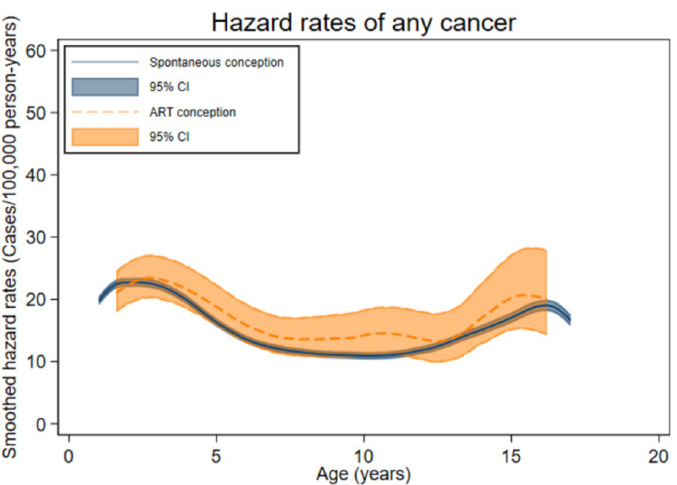
Fig 2. Age-specific hazard rates of first cancer (any type) among spontaneously and ART-conceived children born in Denmark (1994–2014), Finland (1990–2014), Norway (1984–2015), and Sweden (1985–2015) and diagnosed with any cancer before age 18 years. ART, assisted reproduction technology; CI, confidence interval.